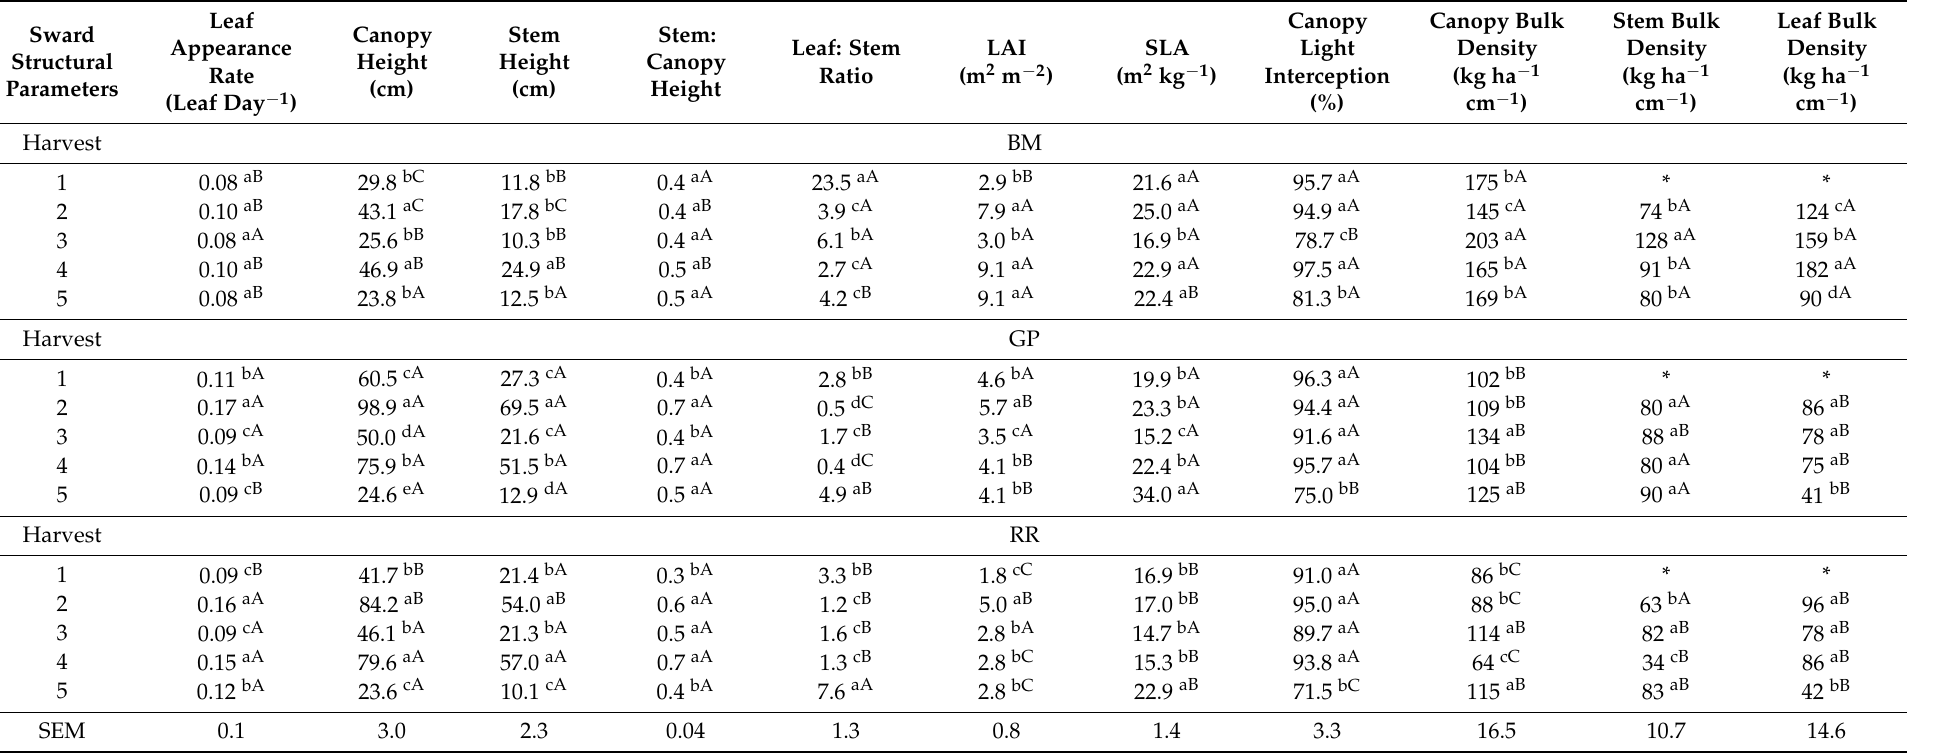
Table 4. Effect of pasture species and harvest on sward structural parameters measured in five harvests at Gatton Research Dairy, Queensland, Australia